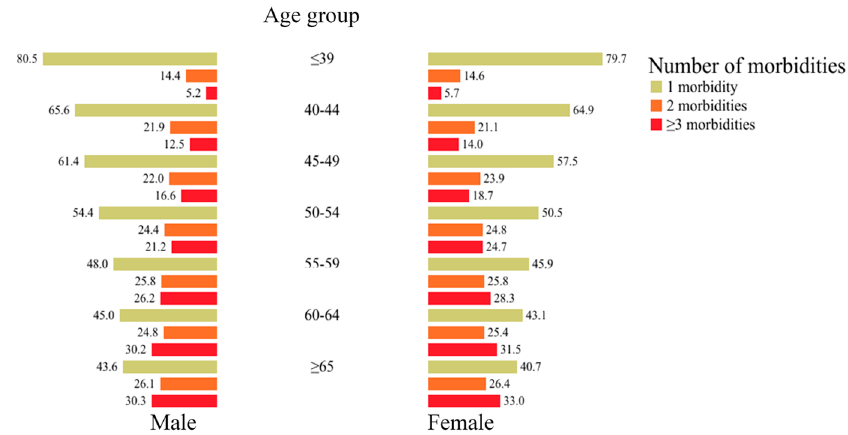
Figure 1. Weighted proportion of patients with chronic morbidities according to age group and gender.